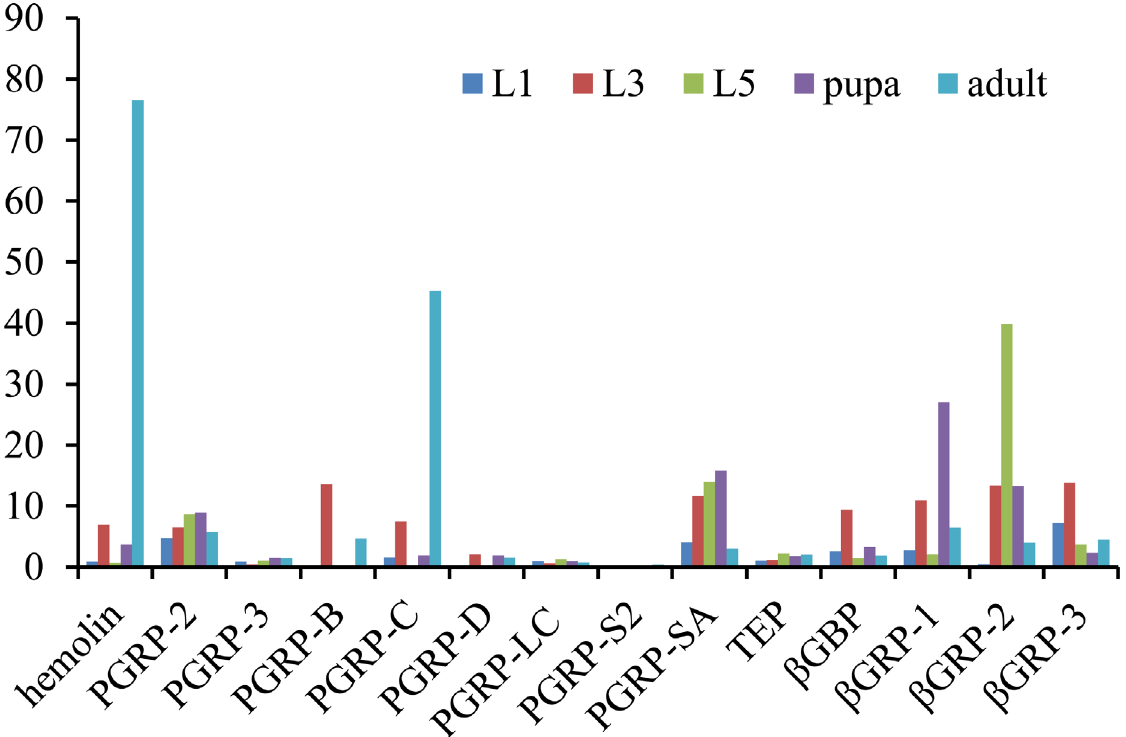
Fig 7. Genes expression of pattern recognition receptors that significantly change in the Pieris rapae transcriptome druing development. Expression levels represent the average transformed numbers of RPKM values of genes in the P . rapae